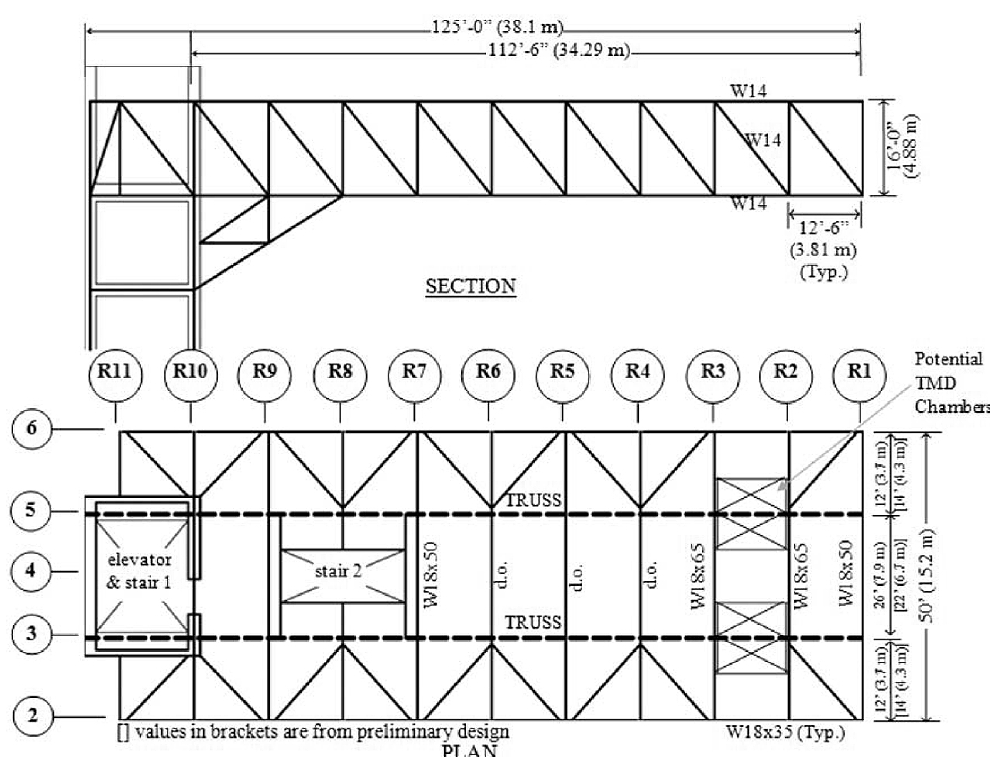
Fig. 2. Plan and section of the